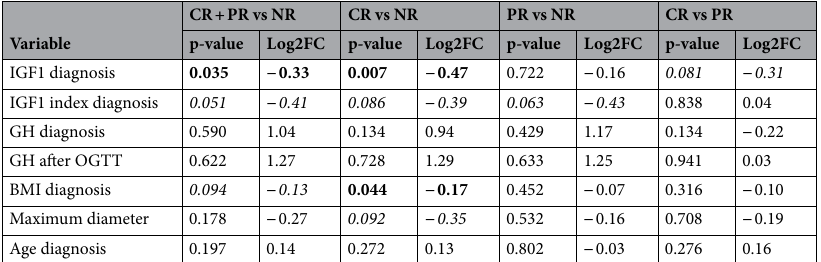
Table 3. Clinical numerical variables showing differences between the evaluated comparisons. The clinical numerical variables that were tested: IGF1 levels measured at diagnosis in each center, IGF1 index at diagnosis, GH levels measured at diagnosis in each center, GH levels measured after a 75 g oral glucose load (OGTT), BMI (Body Mass Index) at diagnosis, maximum tumor diameter in the MRI measured in each center and the age of the patient at diagnosis. T-test or Wilcoxon-test p-values are shown. Statistically significant values (p-value < 0.05) are reported in bold, and p-value < 0.1 in italic Log2FC: Log2 Fold Change.